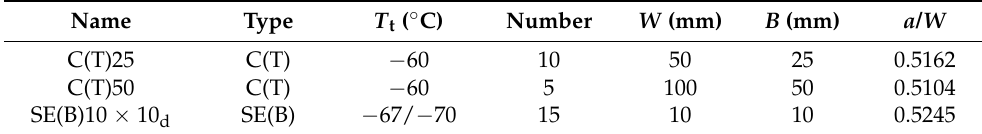
Table 1. Specimen sizes